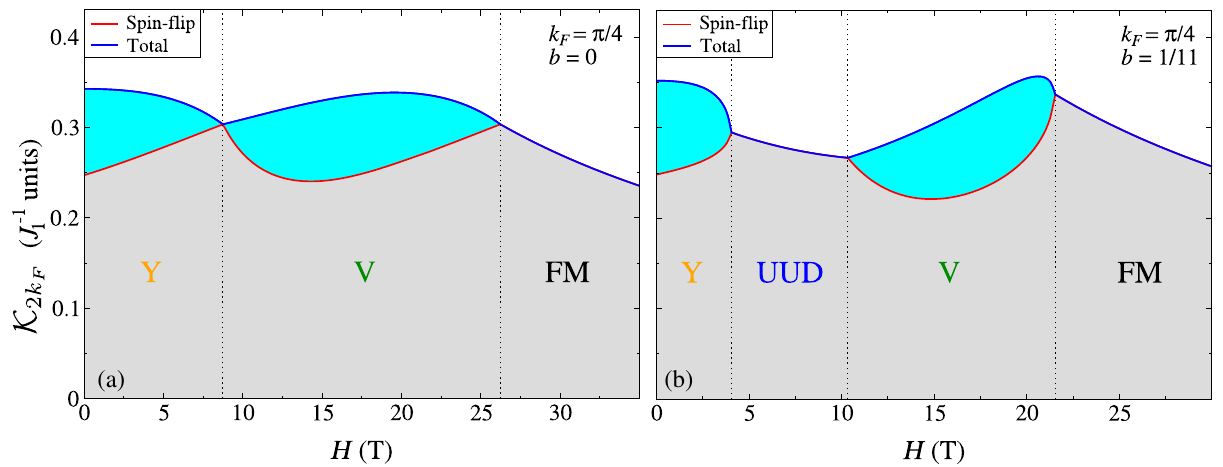
π = 4 and for (a) b ¼ 0 and (b) b ¼ 1 = 11 . Contributions of the spin-flip and non-spin-flip FIG. 8. Kernel K 2 , Eq. (40), vs H for k k F F ¼ channels are represented by shadings; Y, UUD, V, and FM phases and transitions between them are